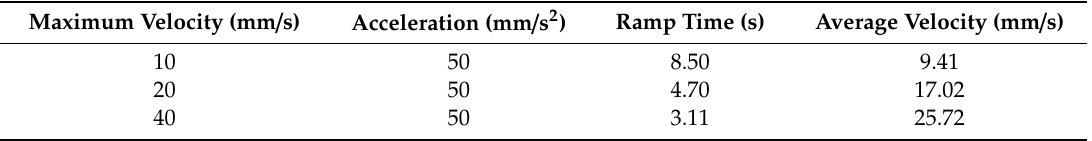
Table 1. Velocity and acceleration of the automatic system used in the